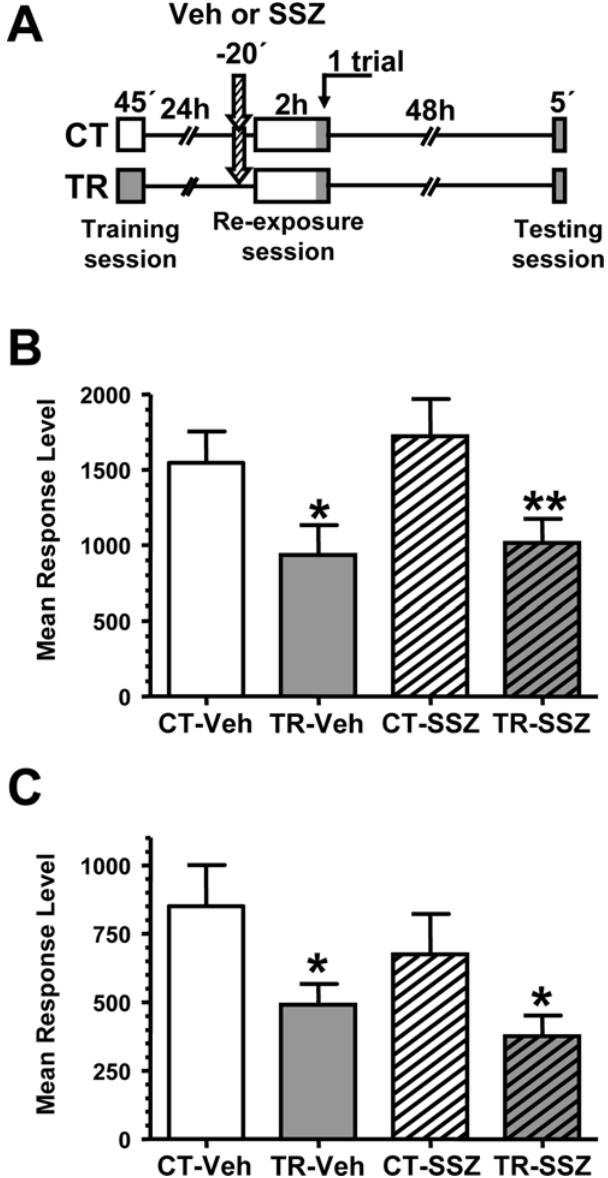
Figure 2. The effect of sulfasalazine injection in memory extinction is cancelled by US presentation during CS re- exposure. A. Experimental design: On day 1 the animals were trained with 15 trials (TR groups) or were located in the training apparatus but remained untrained (CT groups). On day two, a pair of CT-TR groups was injected with 6 m g/g sulfasalazine and the other with vehicle solution (indicated with arrows). 20 min later, all groups were re- exposed to the training context for 2 hours. At the end of the 2h context re-exposure one trial was presented. 48 h after the extinction session the groups were tested for memory retention with one trial in the training context. B. Performance elicited by the trial at the end of the extinction session. C. Performance at testing session. Values are Mean Response Level 6 SEM at testing. *, p , 0.05.